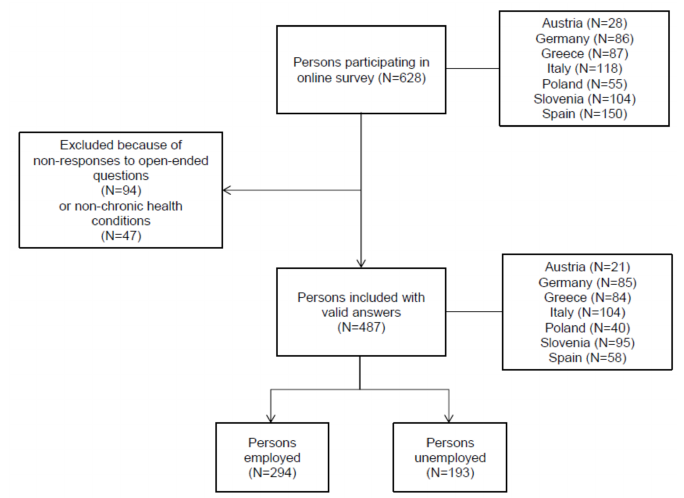
Figure 2. Flowchart of the study selection